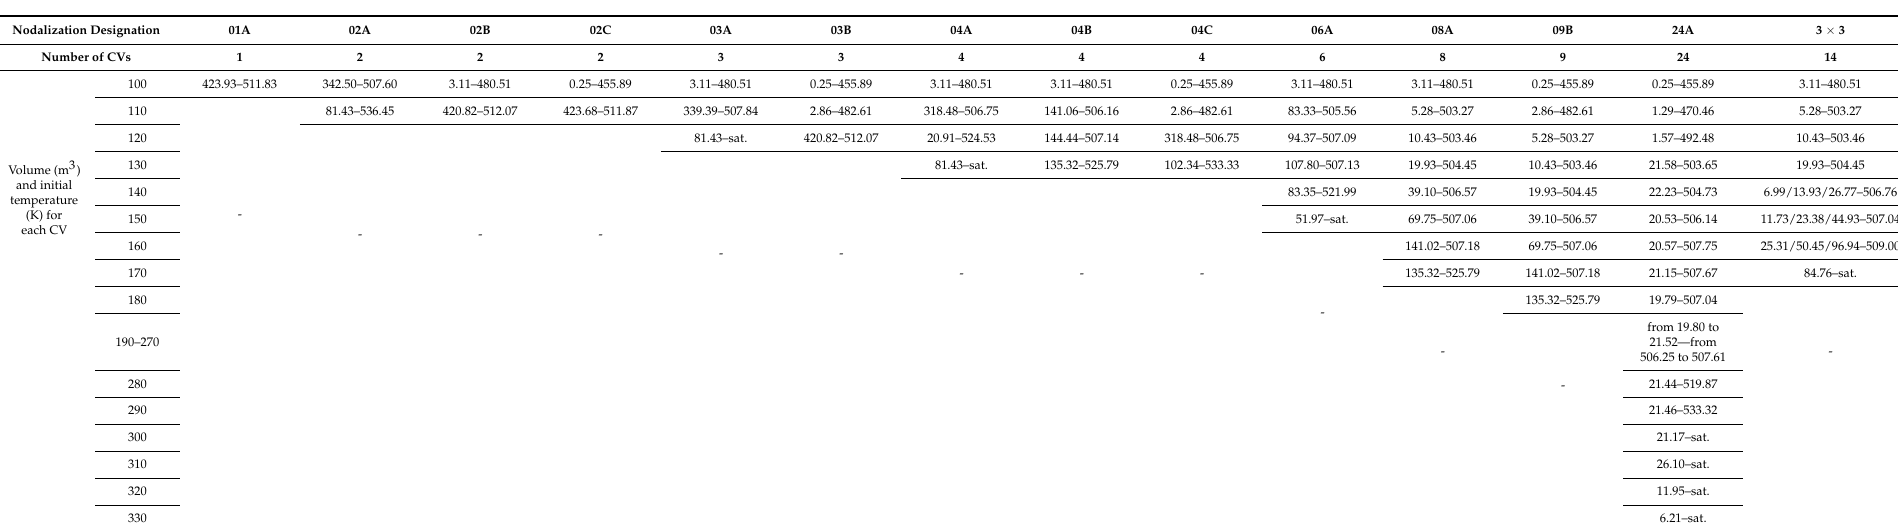
Table 1. List of the models used in the simulations with the geometry data and initial conditions. See also Figure 1. The values in the cells present information about their volume, saturation condition, and